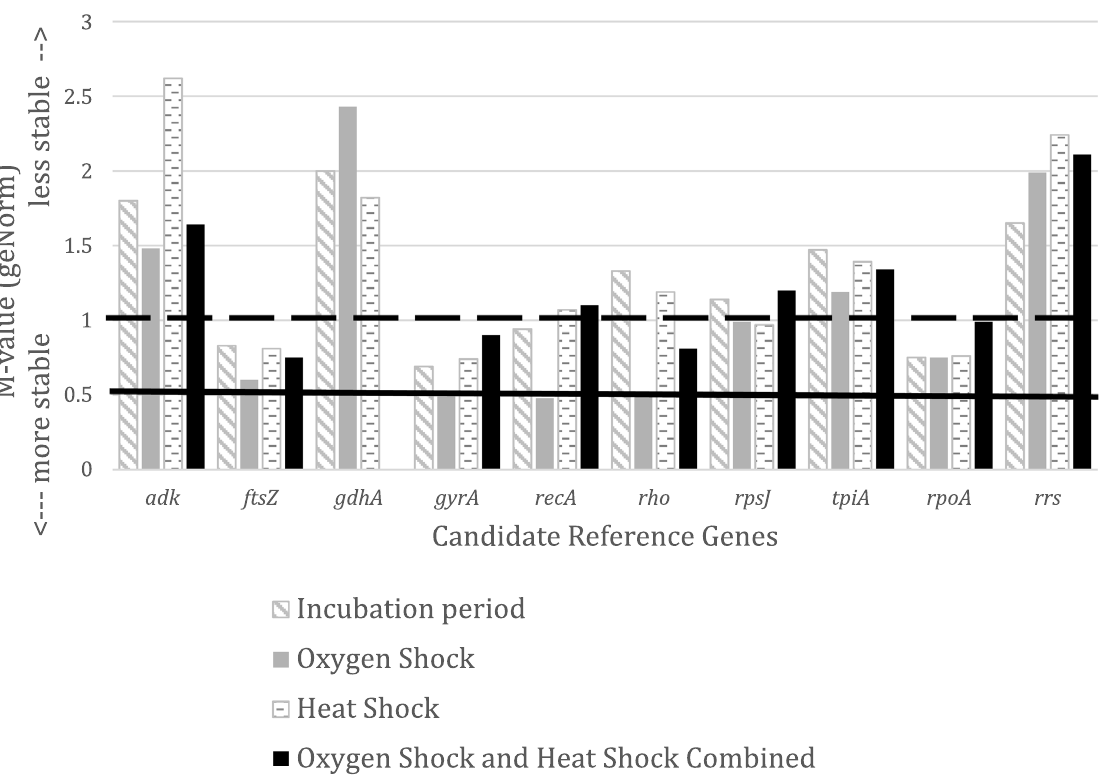
Figure 1. geNorm M-values for the 10 candidate reference genes for each set of growth parameters or stress condition using qbase + software. Medium stability (0.5 < average geNorm M-value < 1.0) is typically seen with heterogeneous